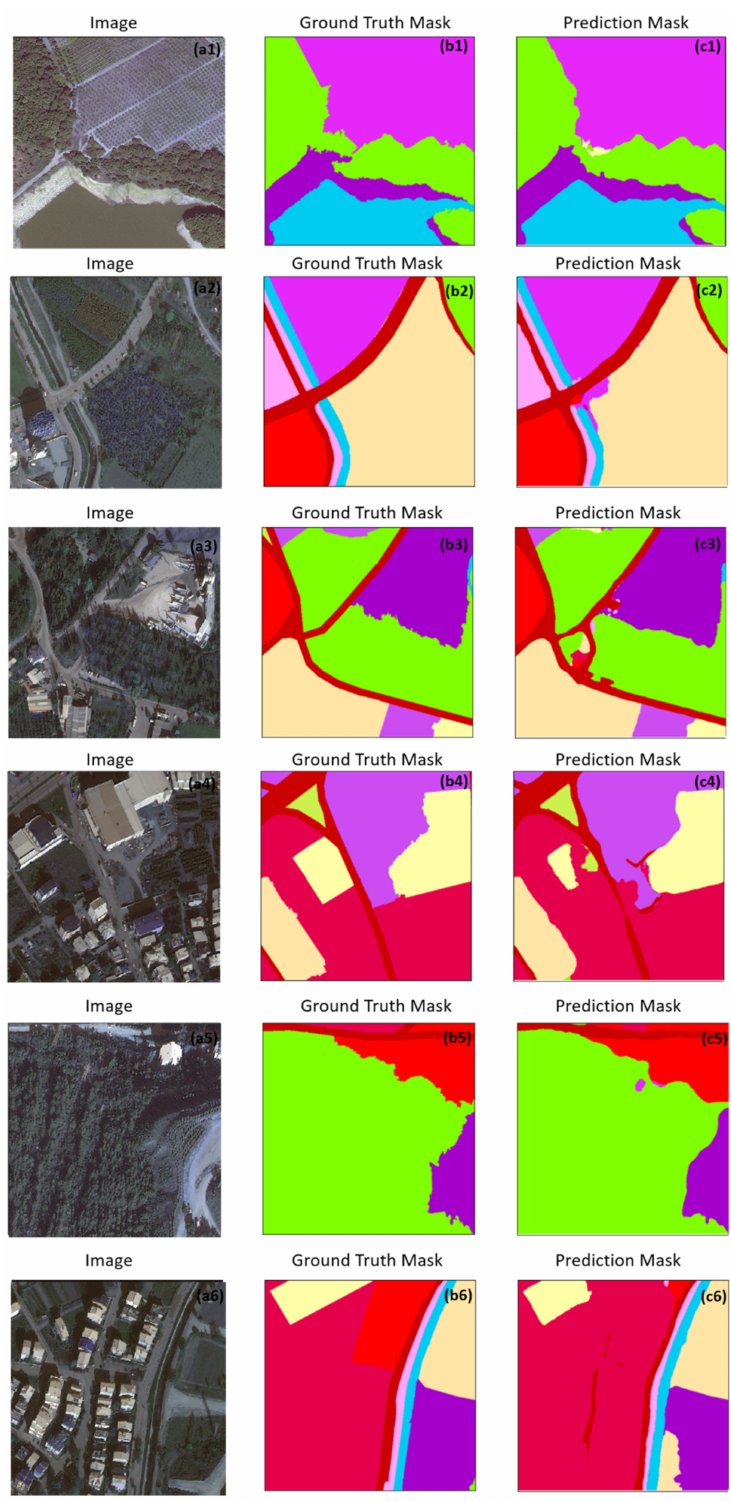
Figure 9. Qualitative results of the classifier trained on the Aksu + Kestel dataset. ( a1 – a6 ) show original image patches; ( b1 – b6 ) illustrate the corresponding Ground Truth masks, and ( c1 – c6 ) show the prediction results with the proposed